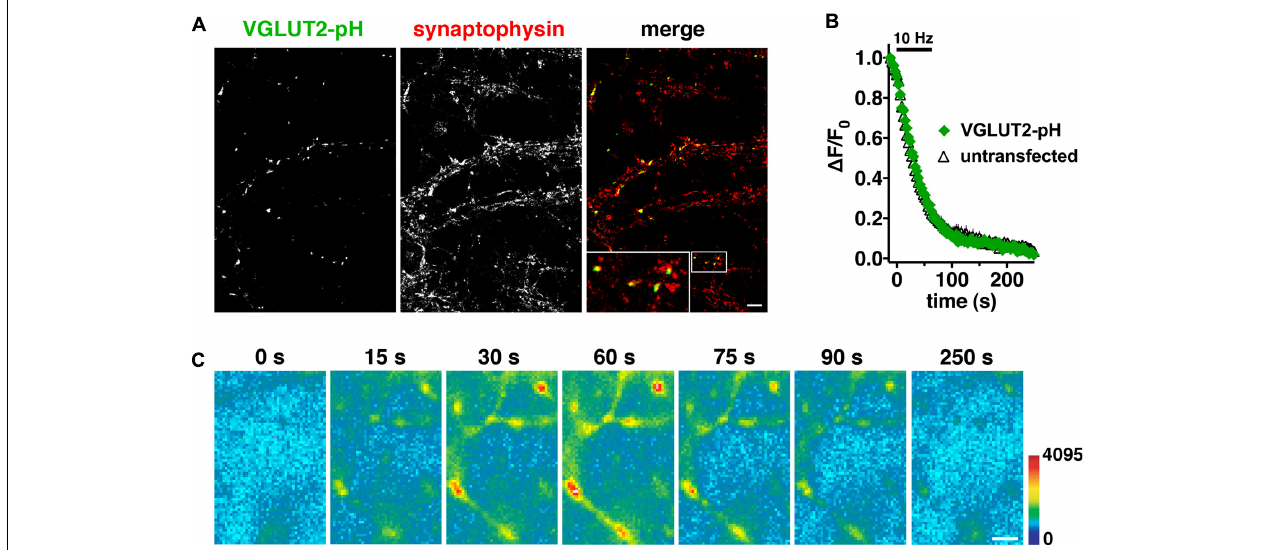
FIGURE 1 | Characterization of a pHluorin-based reporter for studying vesicular glutamate transporter 2 (VGLUT2) recycling in real time. (A) VGLUT2-pH fluorescence co-localizes with synaptophysin at synaptic boutons. Hippocampal neurons transfected with VGLUT2-pH were stained with antibody to endogenous synaptophysin, followed by Cy5-conjugated secondary antibody. Inset shows a 9 × magnification of the designated box. Scale bar, 10 µ m. (B) The rate of FM4-64 destaining is not significantly different between boutons from untransfected (black) and transfected (green) neurons. Data are means ± SEM of the change in fluorescence ( (cid:49) F), acquired every 3 s, normalized to initial fluorescence (average of the first five data points prior to stimulation, F 0 ) over 26–49 boutons per coverslip from four coverslips (n) from two independent cultures for each condition. (C) Time-lapse images show the fluorescence changes of VGLUT2-pH in response to neural activity. After onset of a 10 Hz 60 s stimulus, exocytosis of VGLUT2-pH results in a rapid increase in fluorescence (15, 30, and 60 s), followed by fluorescence decay after the termination of stimulation (75, 90, and 250 s) as vesicles undergo endocytosis and reacidification. Color scale is shown to the right. Scale bar, 2 µ m.